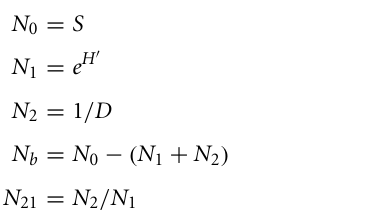
Suggested division of the Mexican Caribbean reefs according to geomorphology: Northern zone (NT), Central zone (CT), and Southern zone (ST). Typical habitats of reef geomorphology in the fringing reef system are illustrated: lagoon (L), crest (C), front (F), slope (S) and terrace (T). Depths in